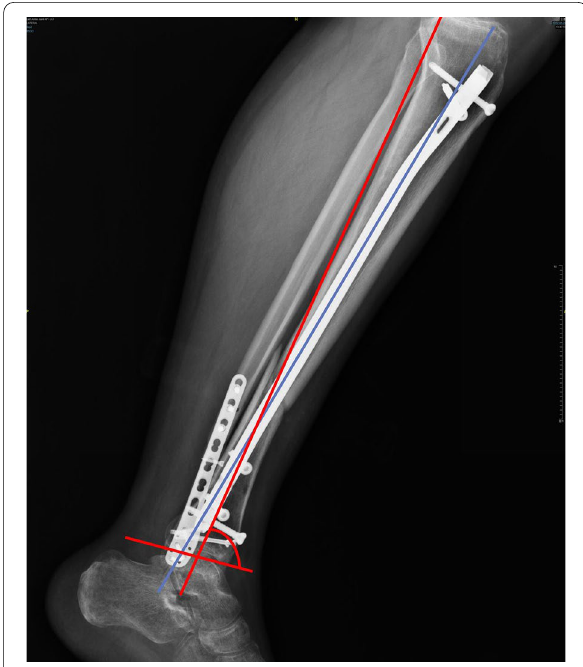
Fig. 5 A case of malalignment following IMN: lateral view, demonstrating the difference between the proximal segment ( blue ) and distal segment ( red )